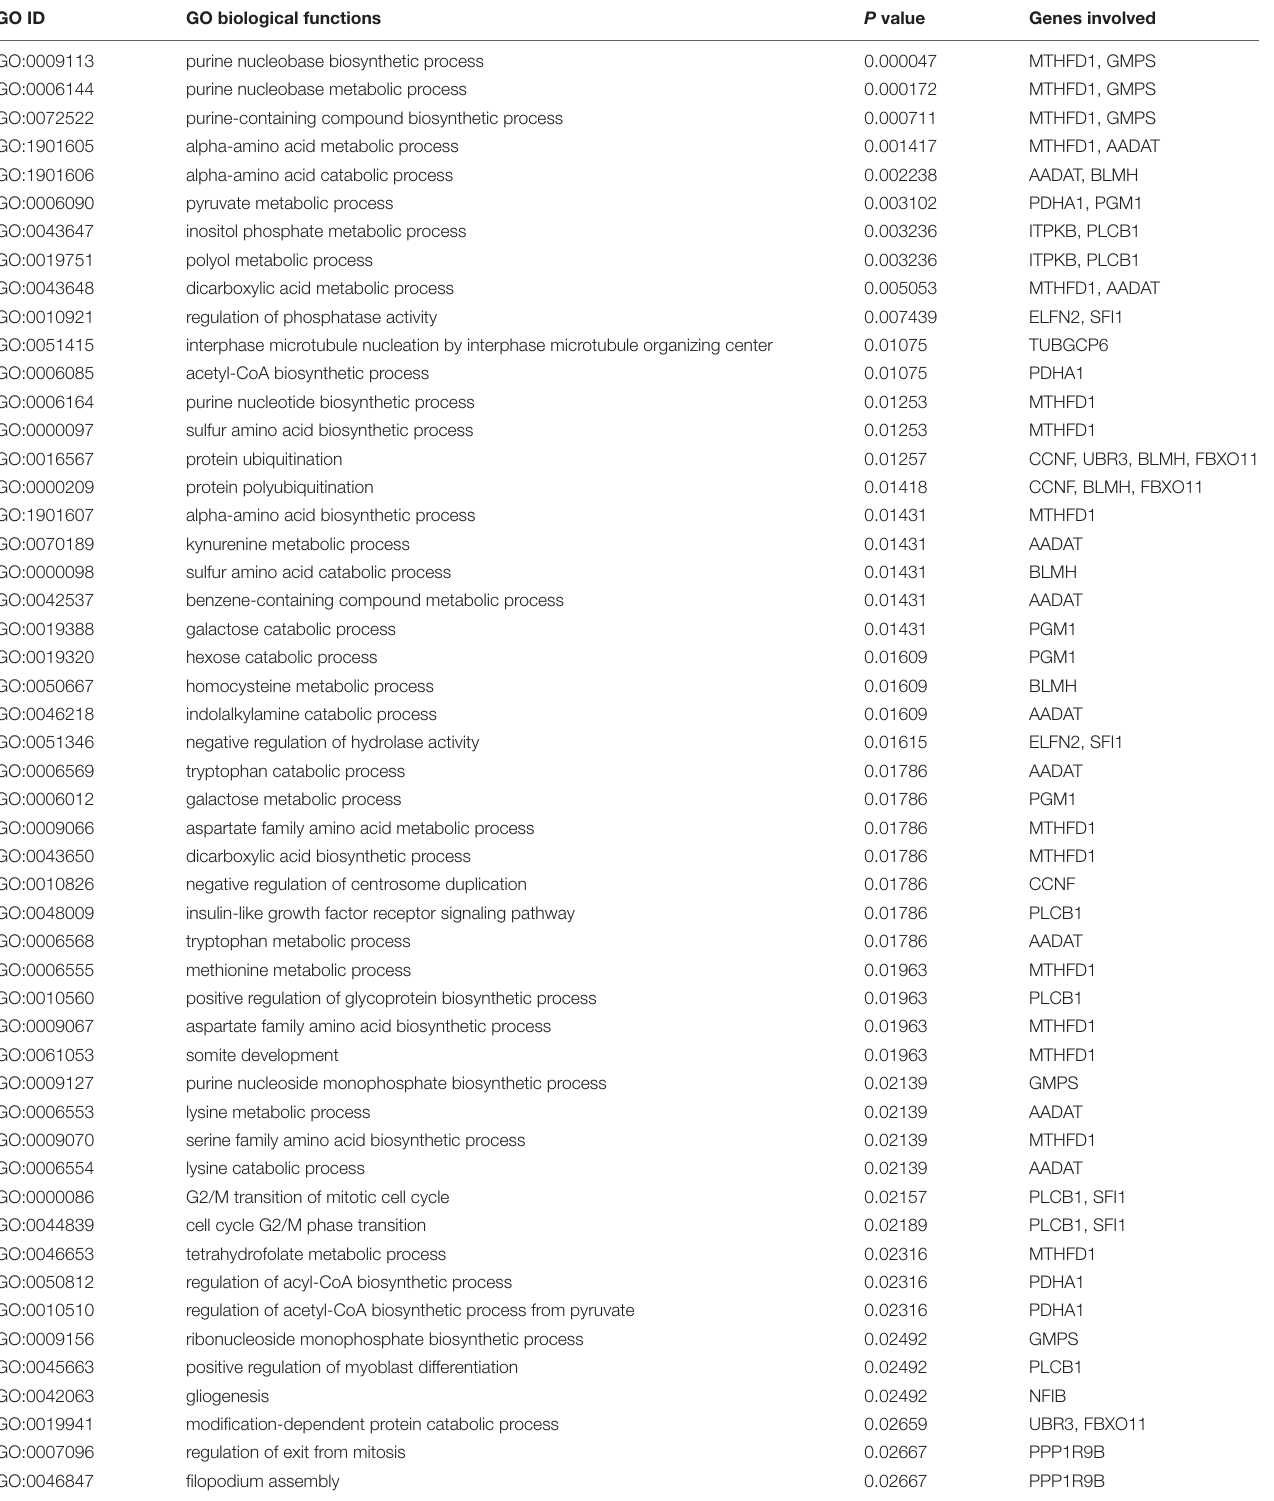
TABLE 1 | Gene Ontology (GO) terms pertaining to growth and metabolism related functions of the genes encoded by the putatively adaptive panel of the SNP loci of T. ilisha populations. GO ID GO biological functions P